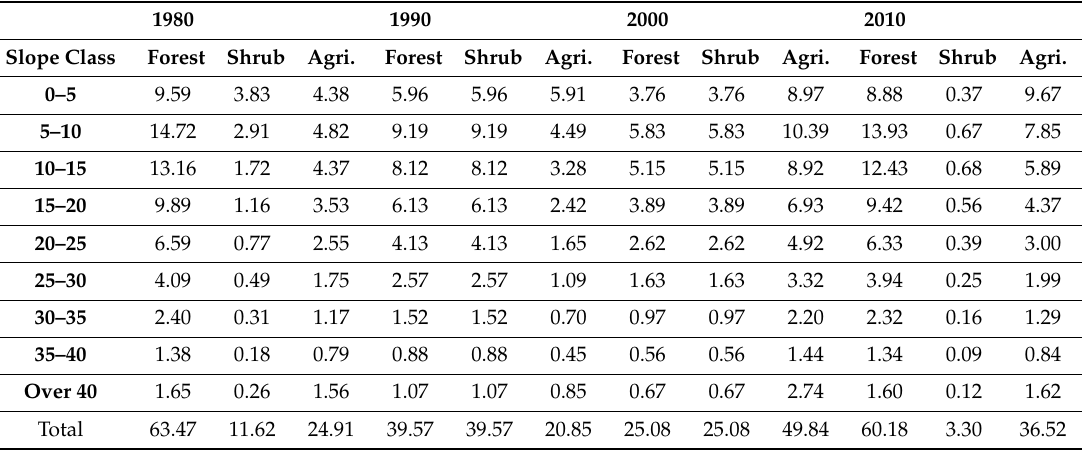
Table 13. Province 7: land use as a percentage of total area of forest, shrubland, and agriculture for 1980, 1990. 2000 and 2010 for entire Nepal. ((Individual land-use area for a slope class / sum of forest + shrubland + agriculture) *